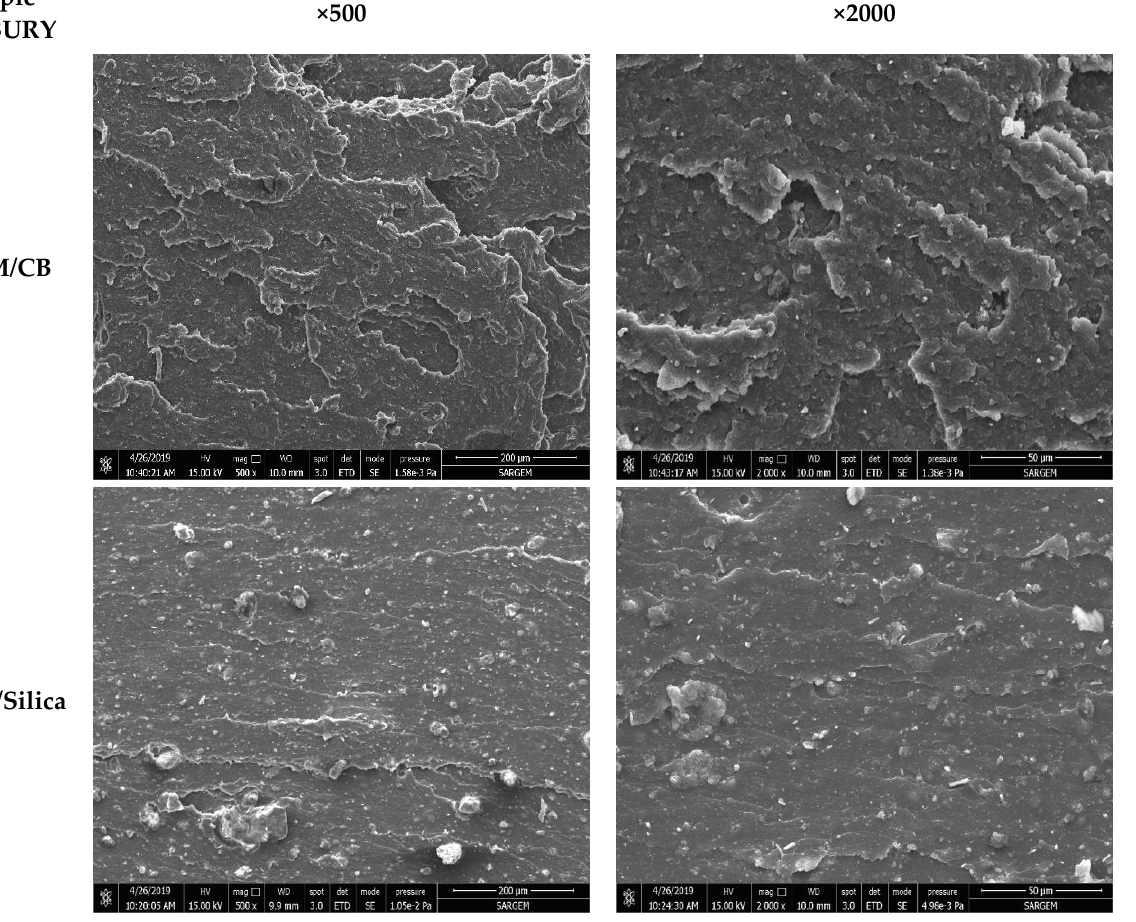
Figure 3. Tensile fractured surface morphologies of the EPDM/CB and EPDM/Silica composites prepared in Banbury (magnification × 500 and × 2000).